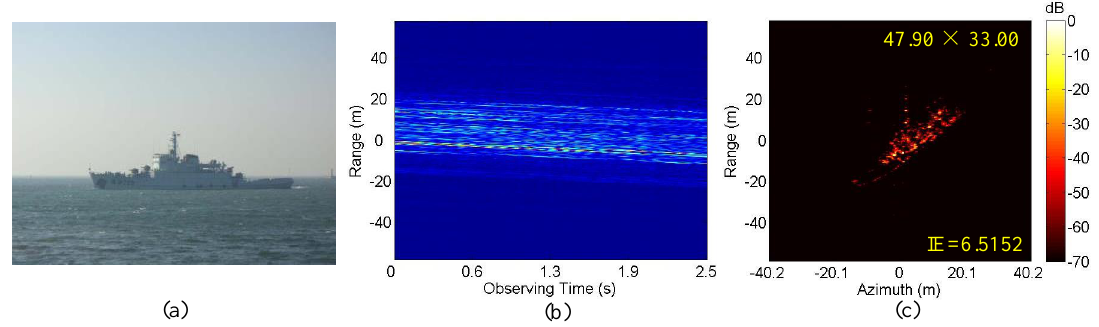
Figure 12. Real data of a ship. ( a ) Optical image. ( b ) HRRPs. ( c ) The ISAR image obtained by the proposed framework. Table 6. The estimated results of ω e (rad/s).